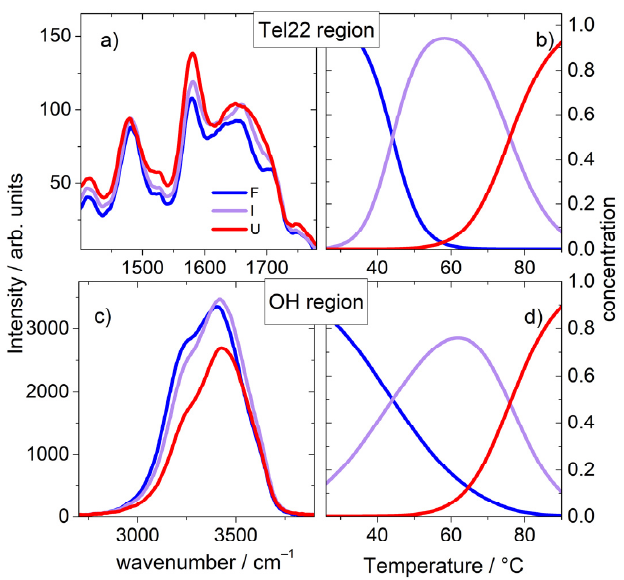
Figure 2. Results of the SVD analysis on UVRR data of Figure 1. Left panels: spectra of significant species for Tel22 ( a ) and OH stretching region ( c ). Right panels: relative concentration of significant species as function of temperature for Tel22 ( b ) and OH stretching region ( d ). Blue, lilac and red colors correspond to folded, intermediate and unfolded states, respectively.